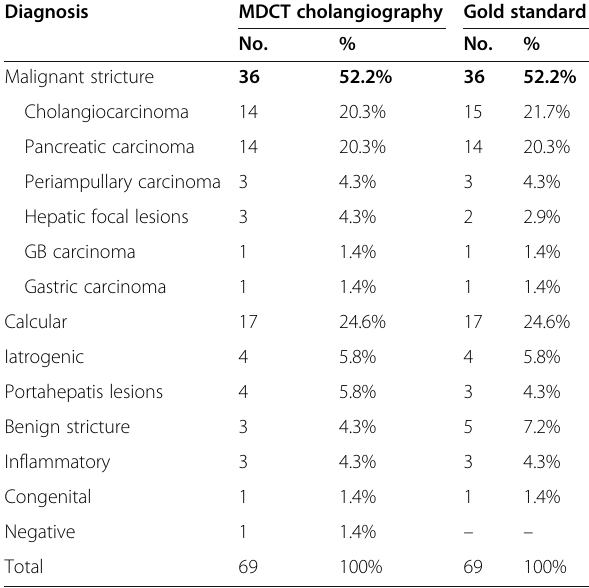
Table 1 MDCT cholangiography and gold standard method diagnosis of the studied cross-section ( N =69) Diagnosis MDCT cholangiography Gold